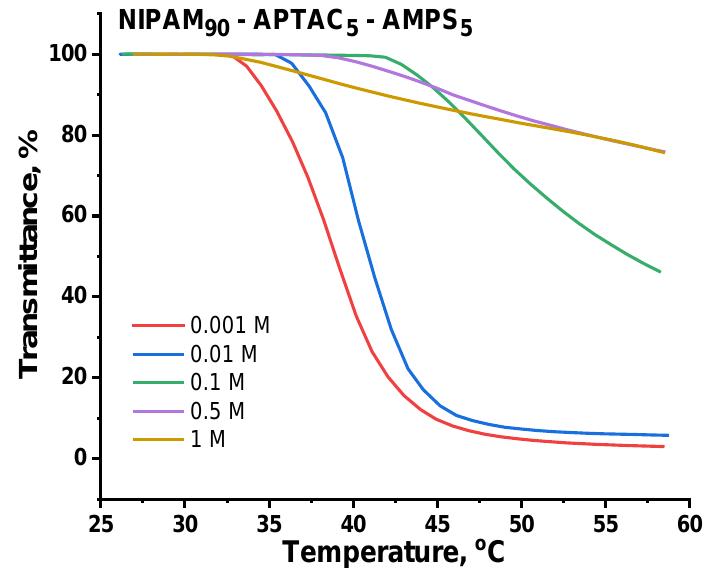
Figure 6. Effect of temperature and ionic strength ( µ ) on transmittance of the nanogel NIPAM 90 - APTAC 5 -AMPS 5 .